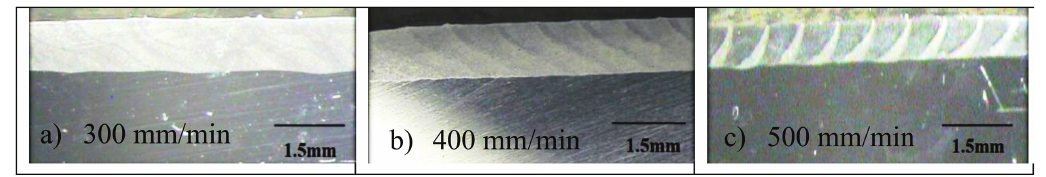
Figure 3: Effect of travel speed on macrostructure.